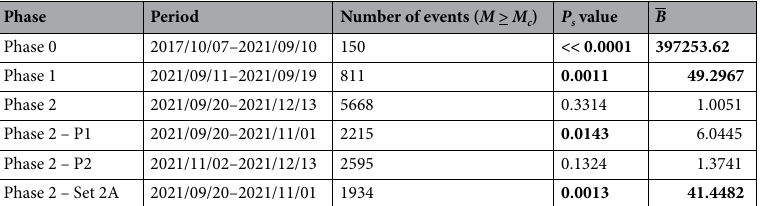
Table 4. Summary of the correlations between tidal stress rate and origin time of the events. P s is the probability that the phase distribution to be random, according to Schuster’s test. B is the upper bound of the Bayes factor calculated as a function of the p -value P s , as told in the “Methods” section. Occurrences where P s < 0.05 or B > 16 are in bold. As in Table 1, Phase 2 has been divided in two periods: P1 [2021/09/20–2021/11/01] and P2